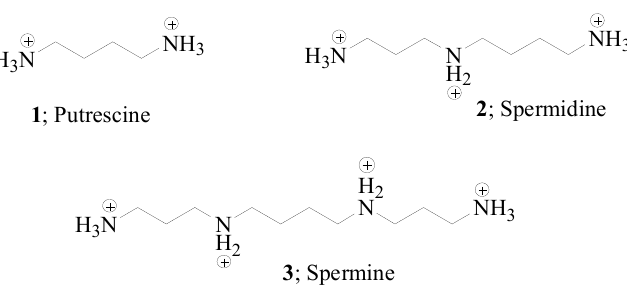
Figure 1. Chemical structures of polyamines 1 – 3 at physiological pH.